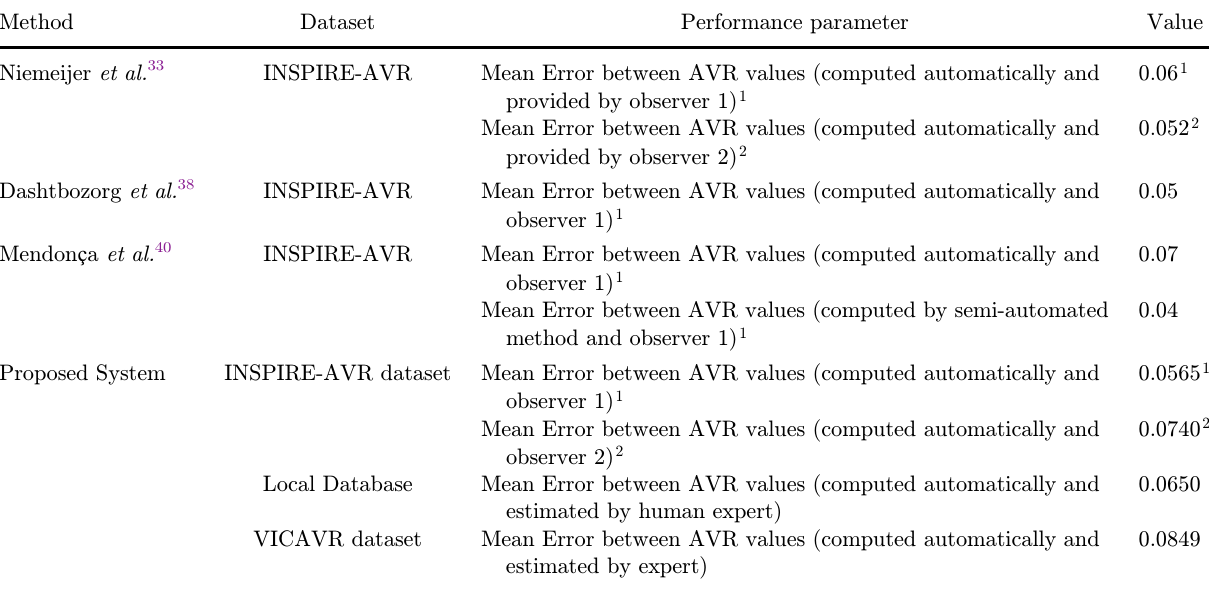
Table 10. Comparison of AVR estimated by the proposed method with previously proposed